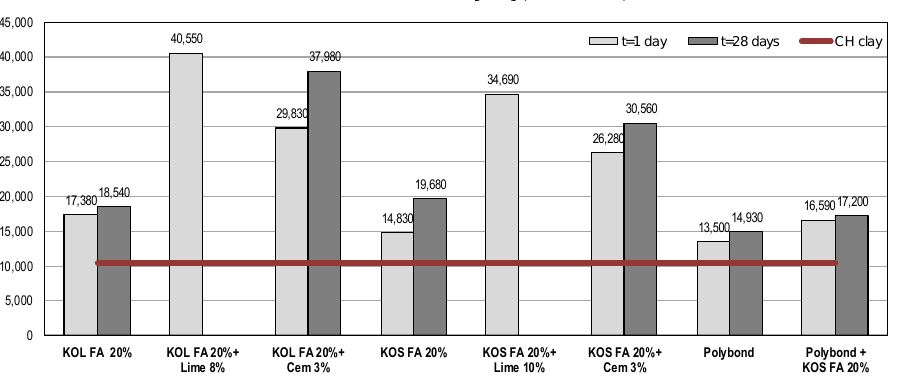
Figure 5. Compressibility parameters of different mixtures with CH clay.